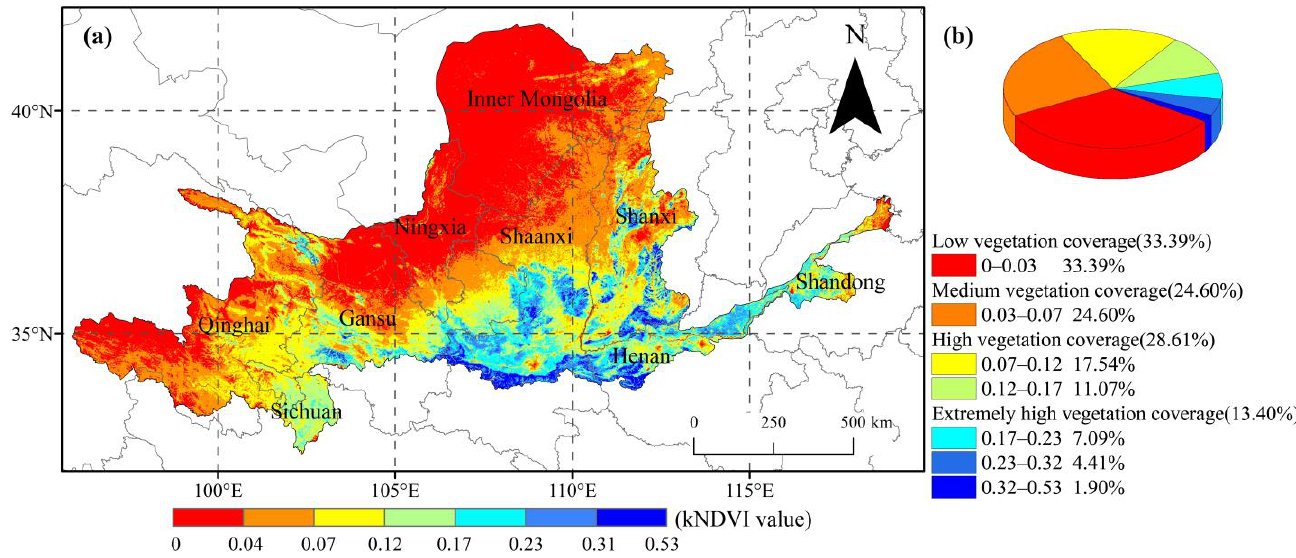
Figure 3. Spatial distribution of the vegetation coverage: ( a ) spatial distribution of median kNDVI from 2001 to 2020 in the YRB and ( b ) the proportions of each classification.